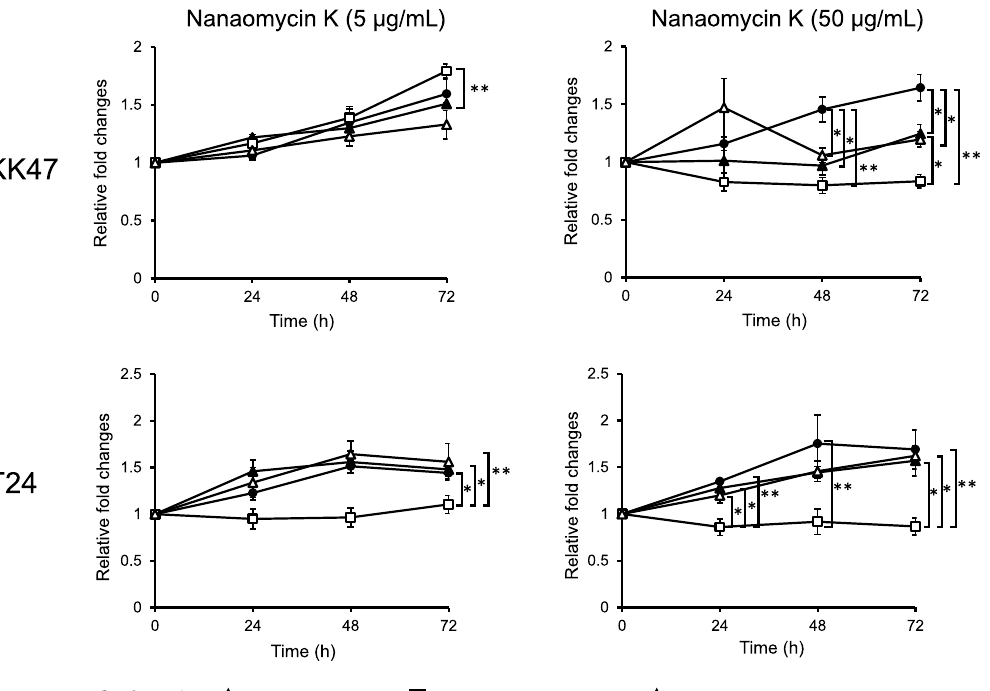
Figure 1. Cell cytotoxicity of nanaomycin K against KK47 and T24 in vitro. In vitro cell proliferation assays in KK47 and T24 cell lines were treated with 5 µg/mL nanaomycin K or 50 µg/mL nanaomycin K, with or without TGF-β, and with or without SB-431542 for 72 h. Control cells were treated with DMSO (vehicle control) (n = 3, average ± SE bars, * p < 0.05, ** p < 0.01). Graphs show the relative fold changes of cell proliferation normalized by that at 0 h